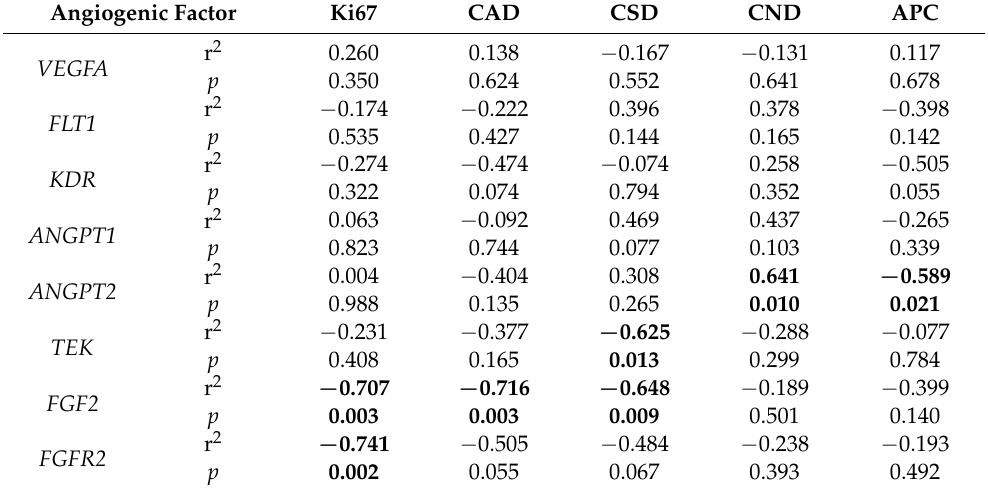
Table 3. Correlation of vascular distribution with the mRNA expression of the major angiogenic factors in the caruncle during the early stage of pregnancy.